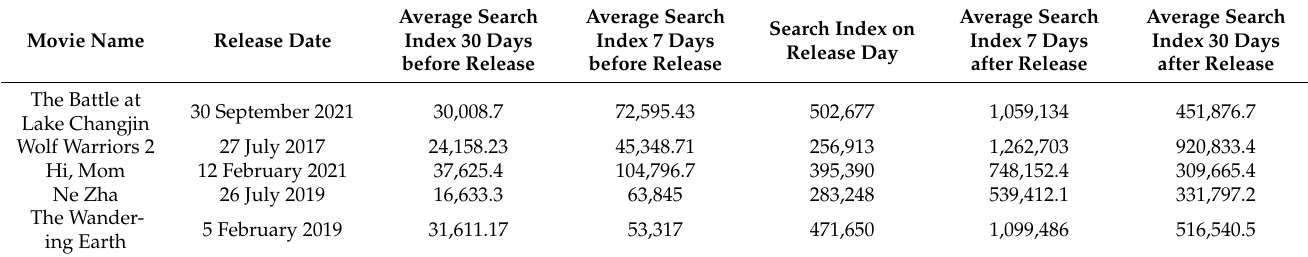
Table 4. Some Baidu search index data examples of